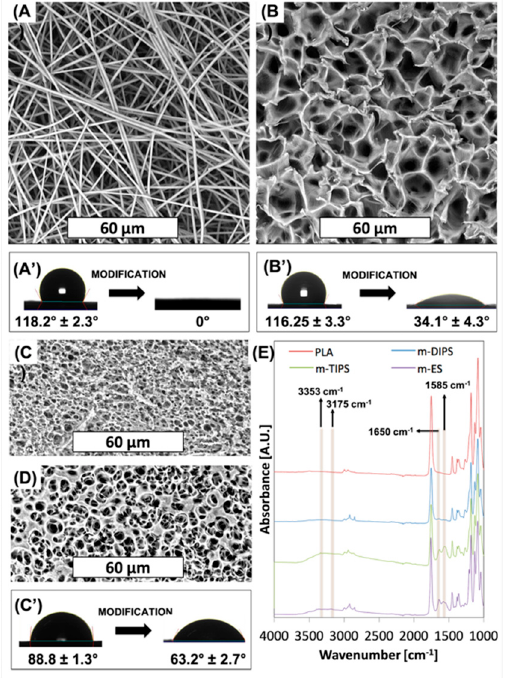
Figure 3. SEM images of ( A ) ES membrane; ( B ) TIPS membrane; ( C ) Front side; and ( D ) back side of DIPS membrane after aminolysis. Effect of surface modification on WCA of ( A’ ) ES membrane; ( B’ ) TIPS membrane; ( C’ ) DIPS membranes; ( E ) FTIR-ATR measurements of PLA and membranes after aminolysis.